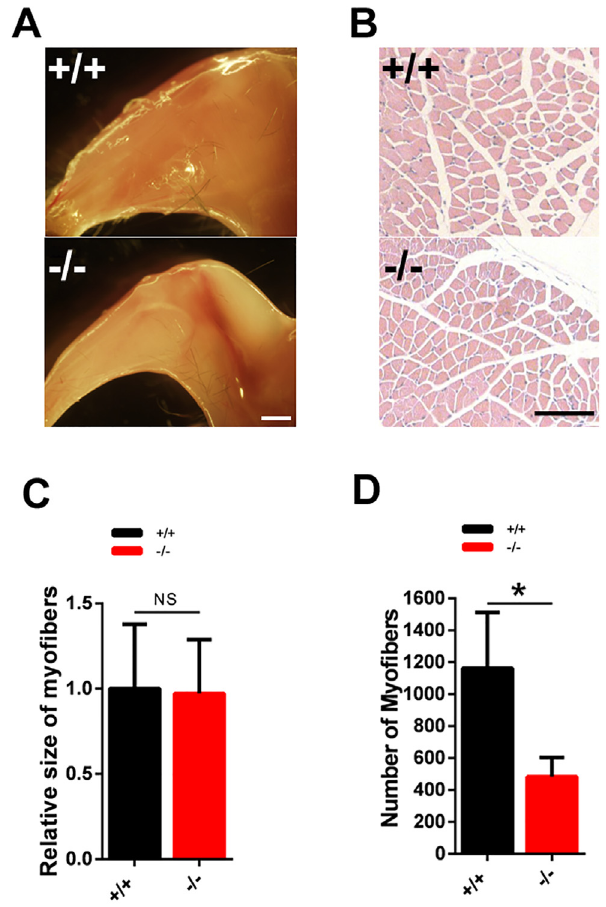
Fig 2. Skeletal muscle phenotype in Trbp mutant and control mice. (A) Gross morphology of the hind legs from 2-week old mice. Scale Bar = 2mm; (B) Hematoxylin and eosin (H&E) staining of transverse section of Tibias anterior (TA) muscle of 2-week-old mice. Scale Bar = 100um; (C) Quantification of myofiber size. (D) Quantification of myofiber numbers of TA muscle. At least 3 mice for each genotype were quantified and data are presented as Mean ± SEM. NS, not significant. +/+, wild type; -/-, Trbp